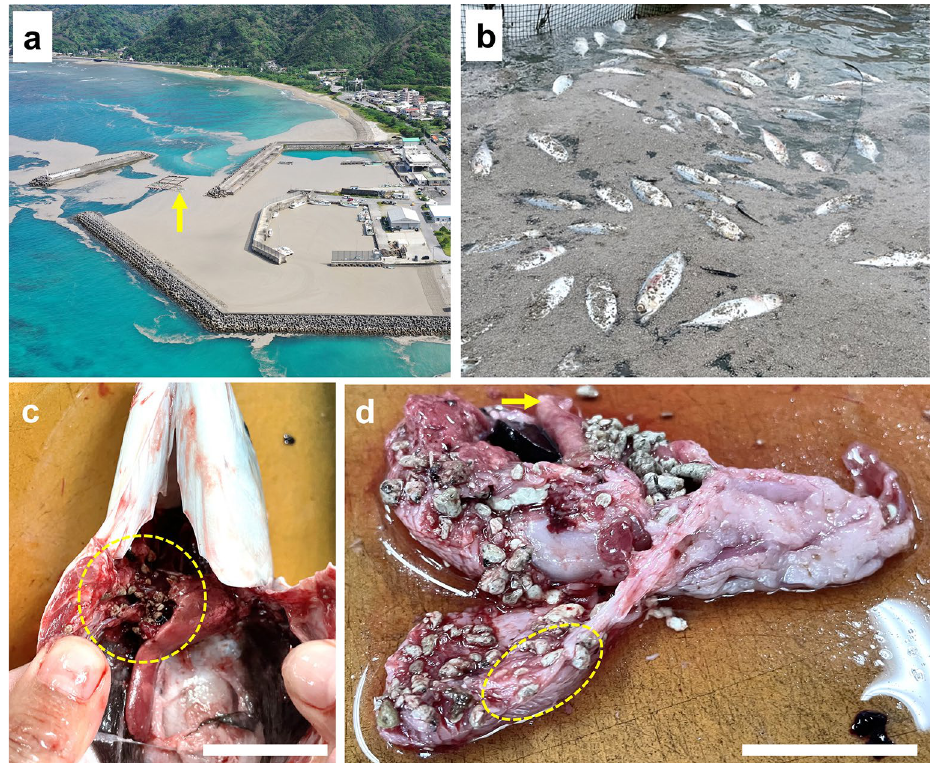
Figure 5. Large quantities of pumice drifted ashore, killing farmed Indian mackerel ( Rastrelliger kanagurta ). ( a ) Aerial image taken by a drone at the Hentona fishing harbor on 24 October 2021; yellow arrow points to the fish cage adjacent to the bay covered with pumice rafts (Hentona fishing harbor: 26°74 ′ 83.84 ″ N, 128°17 ′ 76.33 ″ E). ( b ) A large amount of pumice washed ashore and cultured fish died in the fish cages. The local fishermen association estimated that more than 200 individuals had died by early November. ( c ) When fish were opened, they had swallowed many pumice pebbles (yellow enclosed area: esophagus). ( d ) The appearance of the stomach to the intestines is shown. The yellow arrow indicates the part of the fish from the esophagus to the stomach. The appearance of the intestine is craggy due to the pumice pebbles stuck in the intestine. In the yellow circle, the pebbles in the intestine were transparent and partially came out from